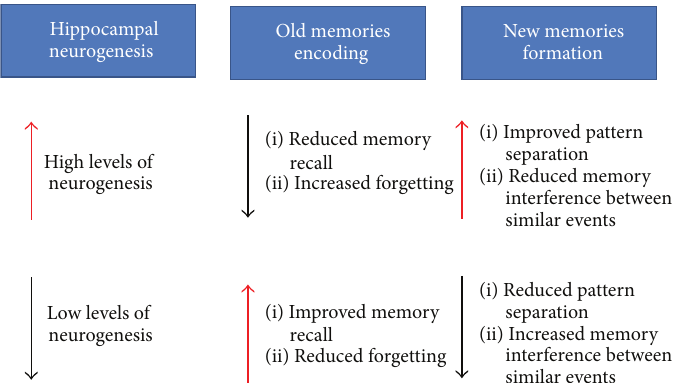
Figure 2: Potential influences of adult neurogenesis on new memory formation and old memory clearance. Increased neurogenesis improves pattern separation when acquiring new information with much overlap and yet accelerates clearance of old memories. Conversely, decreased neurogenesis facilitates the temporal storage of short-term memory and thus enhances memory retrieval in the hippocampus, yet aggravating memory interference of similar events during new information